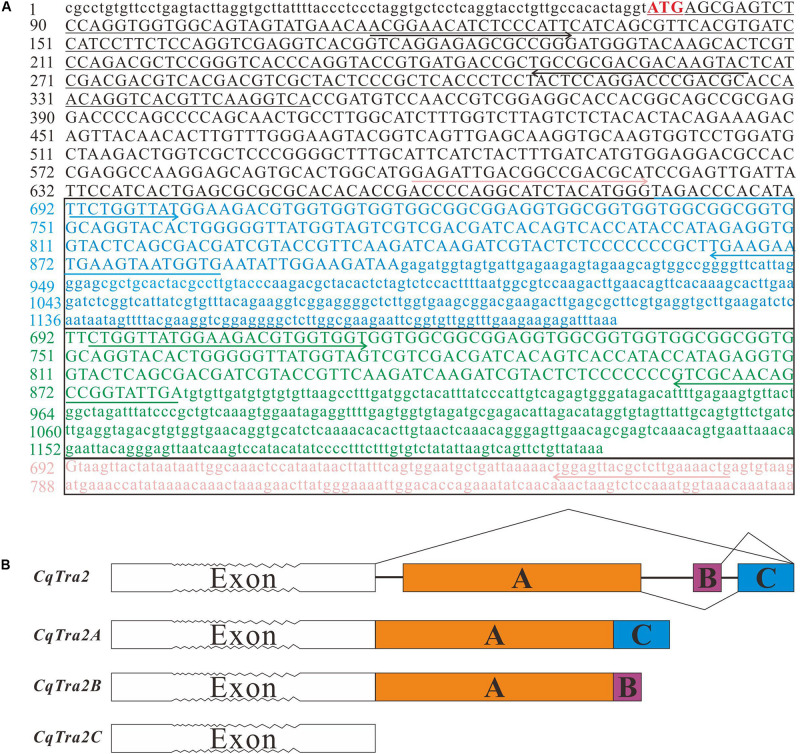
Nucleotide sequences and schematic diagram of Tra2 homologs in C. quadricarinatus. (A) Nucleotide sequences of Tra2 homologs (CqTra-2A, CqTra-2B, and CqTra-2C). The start codon (ATG) is marked with a red background. The nucleotides are numbered on the left. The lower-case letters indicate 5′ and 3′ untranslated regions, and upper-case letters indicate the coding region. The different colors represent the specific region of the three spliced isoforms, in which blue represents CqTra-2A, green represents CqTra-2B, and orange represents CqTra-2C. The different colored solid line arrows show the primers used in RT-PCR for the three different isoforms. Underlining represents the sequence used to synthesize the dsRNA for RNAi. (B) Schematic representation of the genomic sequence of CqTra2 and pre-mRNA splicing. White boxes with serrated teeth indicate mutual exons but not exact numbers of exons. Colored boxes show the alternatively spliced exons. The solid lines show introns, the crease lines show the manner of alternative splicing of Cqtra2 pre-mRNA.